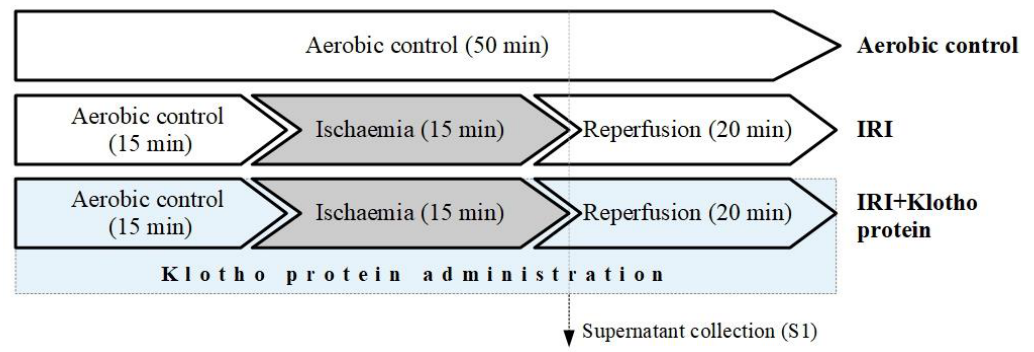
Figure 7. Experimental protocol for in vitro chemical ischaemia/reperfusion injury to the cardiomyocytes, with and without Klotho administration; IRI — ischaemia/reperfusion injury.